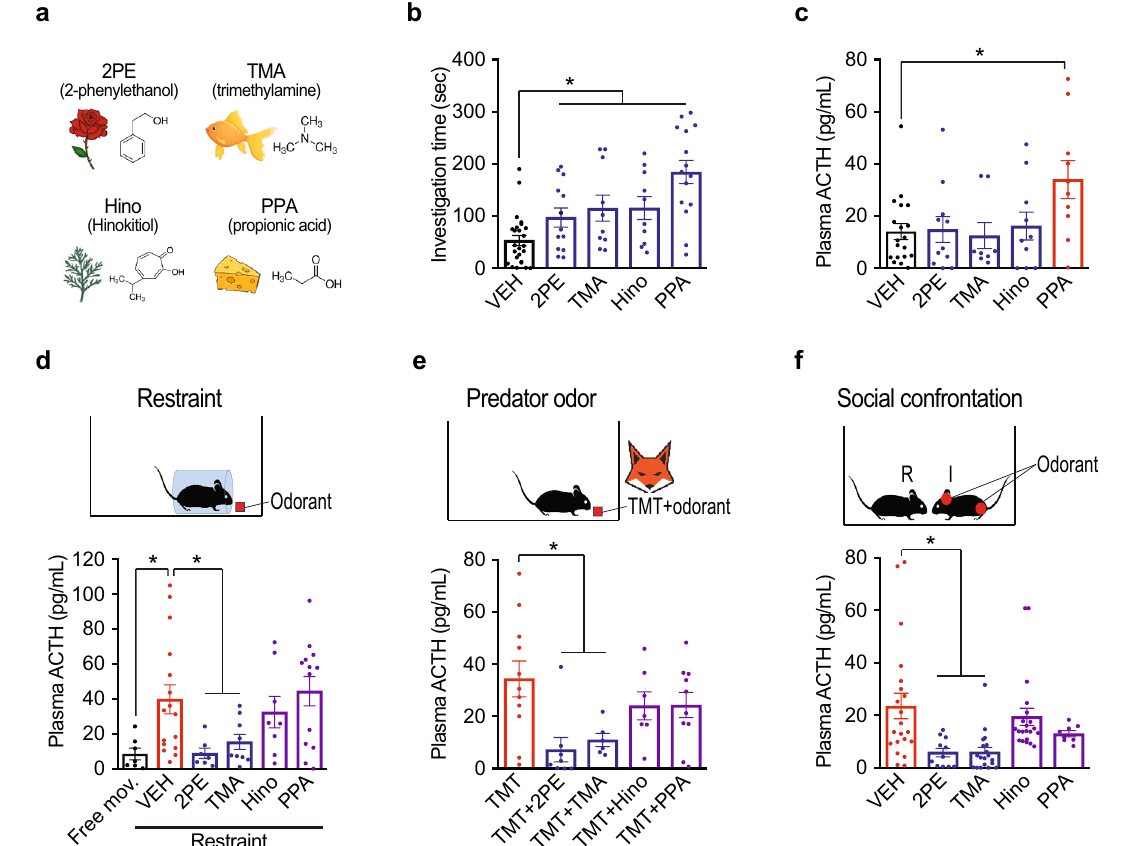
Figure 1. Certain odorants block stress hormone responses to diverse stressors. ( a–c ) Four odorants with different structures and perceived odors ( a ) were attractive (blue) to mice compared to vehicle (VEH) (gray) based on investigation time ( b ). Whereas one odorant (PPA, red) induced an increase in stress hormone (plasma ACTH) compared to vehicle, the others (blue) did not ( c ). n = 8–25 per condition. Unpaired t test, *P < 0.05. ( d ) Plasma ACTH was measured in freely moving animals (Free mov.) (gray) or in animals subjected to physical restraint in the presence of vehicle (VEH), 2PE, TMA, Hino, or PPA. Physical restraint caused an increase in stress hormone (red), which was blocked by exposure to 2PE or TMA (blue), but not Hino or PPA (purple). n = 7–16 per condition. Unpaired t test, *P < 0.05. ( e ) Predator odor (TMT, red) exposure stimulated an increase in plasma ACTH that was also blocked by 2PE or TMA (blue), but not Hino or PPA (purple). n = 6–19 per condition. Unpaired t test, *P < 0.05, **P < 0.01. ( f ) Social confrontation induced an increase in plasma ACTH when a resident male (R) was exposed to an intruder male (I) (VEH, red). Painting the intruder head and genital region with 2PE or TMA (blue), but not Hino or PPA (purple), blocked the stress hormone increase. n = 8–21 per condition. Unpaired t test, *P < 0.05. Column heights indicate means, error bars indicate S.E.M., and dots in the same column indicate different determined the number of PRV+ neurons and PRV+ nFos+ neurons in individual brain areas and calculated the percentage of PRV+ neurons that were nFos + in a given area (nFos+ &PRV+/PRV+ (%)). 2PE caused a striking decrease in the activation of upstream BNSTa neurons by both restraint and TMT (Fig. 2c). Whereas 51.4 ± 8.4% of PRV+ BNSTa neurons were nFos+ following restraint alone, 7.3 ± 4.6% were nFos+ following exposure to restraint plus 2PE, a decrease of sevenfold. And while 47.0 ± 7.6% of PRV+ BNSTa neurons were nFos+ after exposure to TMT, 16.7 ± 4.5% were nFos+ after exposure to TMT plus 2PE, a decrease of 2.8-fold. In contrast, 2PE had no discernible effect on restraint activation of PRV+ neurons in the ARC and little or no effect on TMT activation of PRV+ neurons in LPGi (Fig. 2d,e). It has been reported that rose oil decreases TMT-induced neuronal activation in a part of BNST 19 . However, the present results show an effect of a monomo- lecular odorant on a specific subset of BNST neurons: BNSTa neurons upstream of CRHNs. They also show an inhibitory effect not only on the response to TMT, but also on the response to another stressor, physical restraint. To determine whether the stressor activated neurons in the BNSTa are excitatory or inhibitory, tissue sections were costained for PRV, nFos, and markers of excitatory glutamatergic neurons (Vglut1 and Vglut2) or inhibitory GABAergic neurons (Gad1 and Gad2). These experiments showed that the majority of BNSTa neurons upstream of CRHNs are glutamatergic. Whereas 73.1 ± 7.1% of the PRV+ neurons were colabeled for glutamatergic makers only 23.8 ± 1.8% were colabeled for GABAergic markers (Fig. 2f).